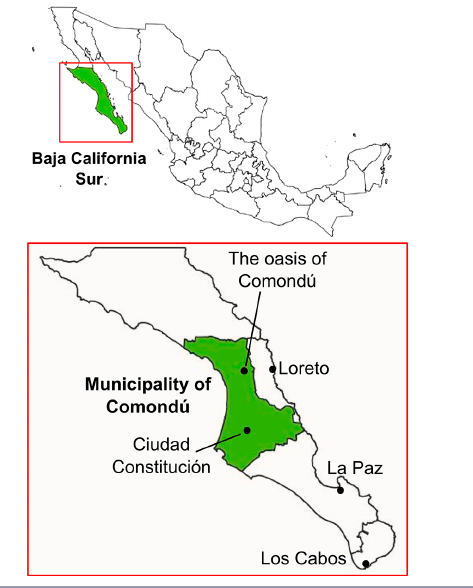
Fig. 1 . Location of the oasis of